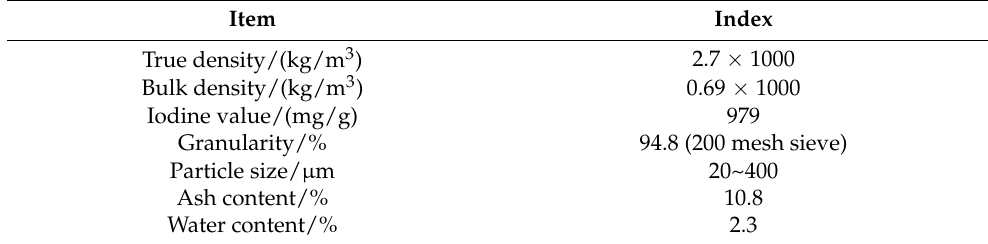
Figure 1. Process flow diagram of PAC-HUM. Table 1. Properties of PAC (type: ICT200).